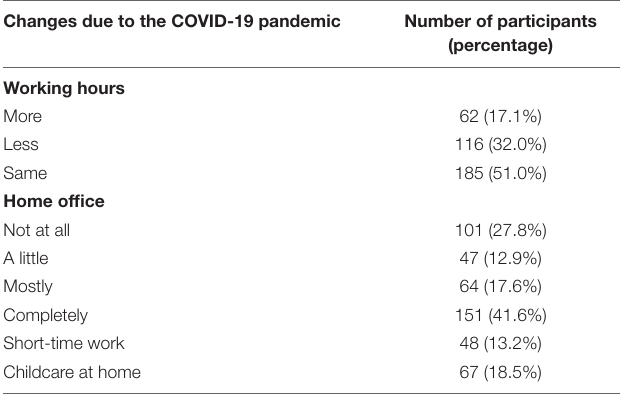
TABLE 1 | Work-related changes due to the COVID-19 pandemic experienced by participants. Changes due to the COVID-19 pandemic Number of participants